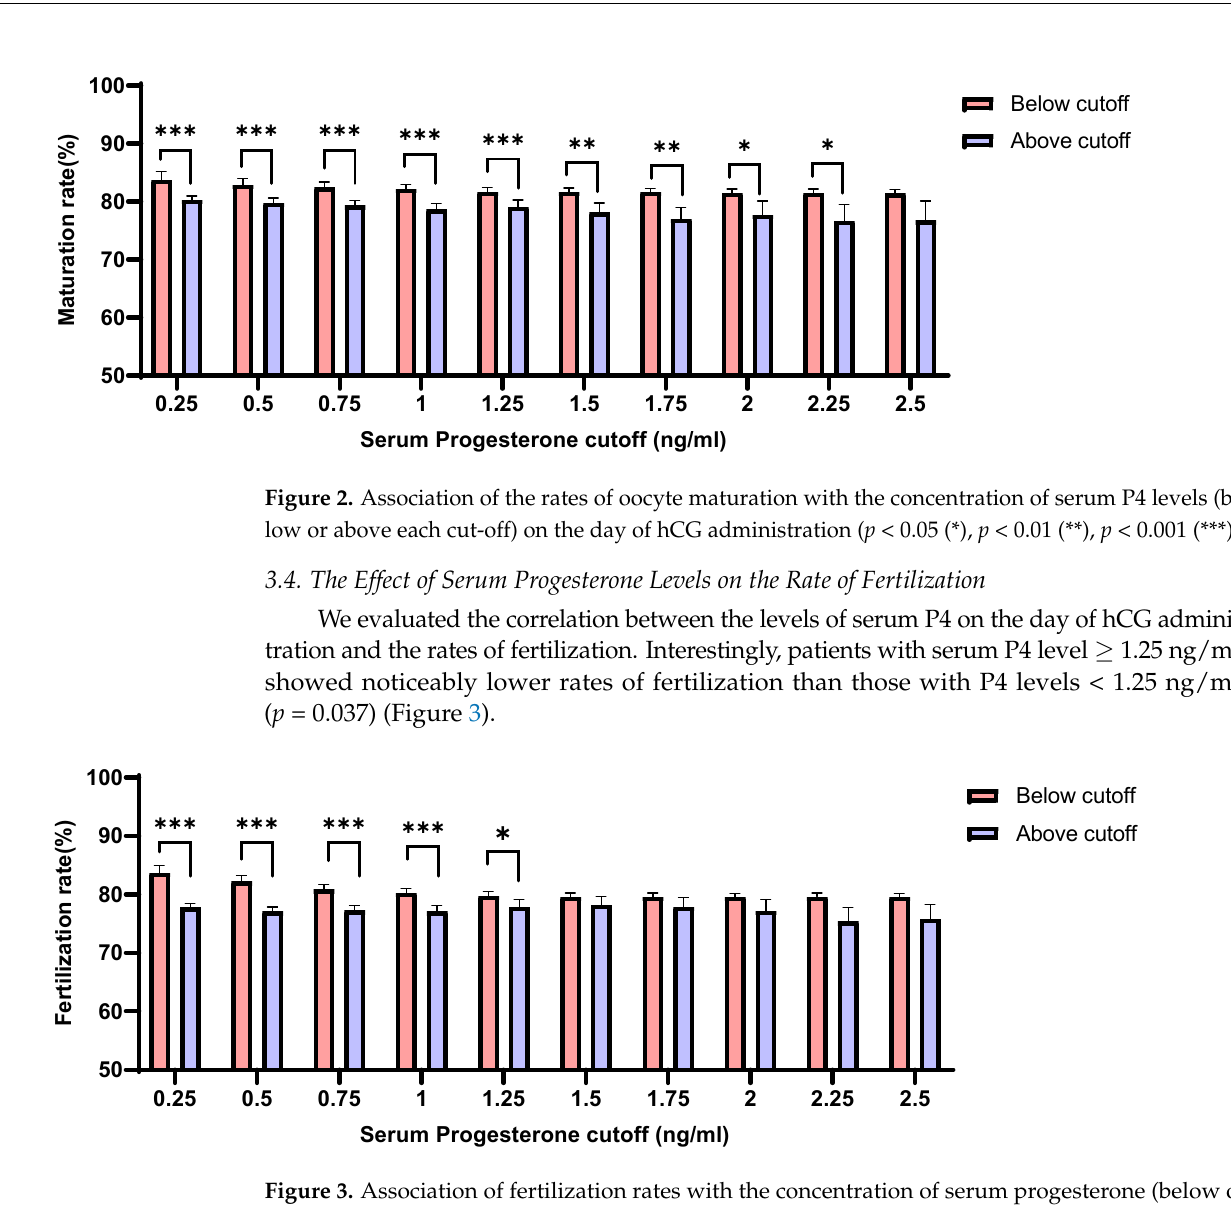
Figure 3. Association of fertilization rates with the concentration of serum progesterone (below or above each cut-off) on the day of hCG administration ( p < 0.05 (*), p < 0.001 (***)). 3.5. The Effect of Serum Progesterone Levels on the Rate of Good-Quality Embryo (GQE) Patients with serum P4 level ≥ 1.75 ng/mL on the day of hCG administration showed a negative association with GQE rates at the cleavage stage (CL) (Figure 4A). However, there was no significant association observed between serum P4 levels and the rates of GQE at the blastocyst stage (BL) (Figure 4B). 3.6. The Effect of Serum Progesterone Levels on the Various Parameters According to Patient’s Age We next evaluated the effect of serum P4 levels on the rates of oocyte maturation, fertilization, and embryo development, depending on the age of patient. Table 3 shows the correlation analyses of the rates of oocyte maturation, fertilization, and GQE development within the association of P4, P4/oocyte, or P4/E2. P4/oocyte denotes the serum P4 level on the day of hCG administration divided by the number of oocytes retrieved. Moreover, P4/E2 indicates the serum P4 level divided by the peak E2 level on the day of hCG admin- istration. Intriguingly, it was observed that the rates of GQE development at the cleavage stage were significantly decreased as the serum P4 levels increased in the 40–45-year-old patient group ( p =